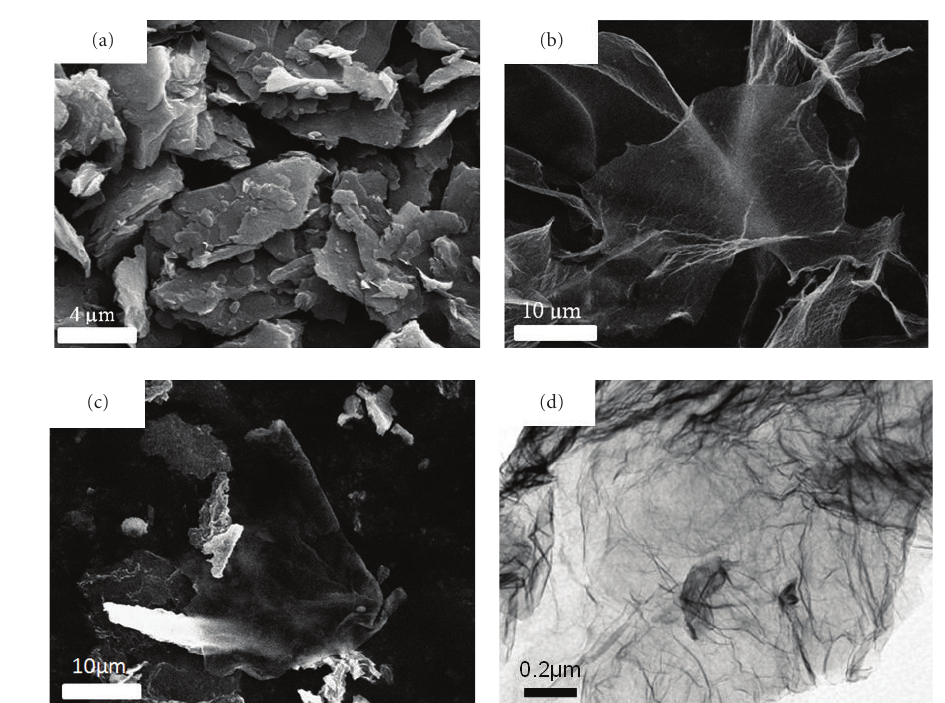
Figure 6: SEM (a, b, c) and TEM (d) images of graphite (a), XGO (b), and RGO (c,